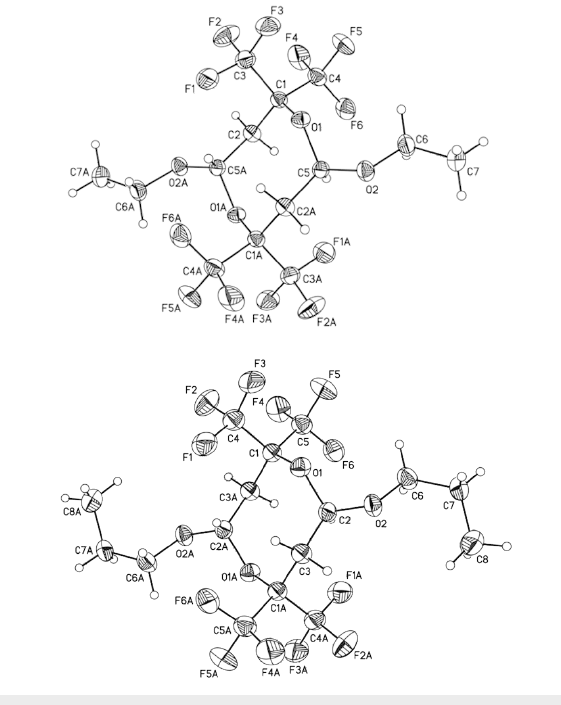
Figure 1: ORTEP drawing of compounds 2a and 2b with thermal ellipsoids drawn to the 50% probability level.